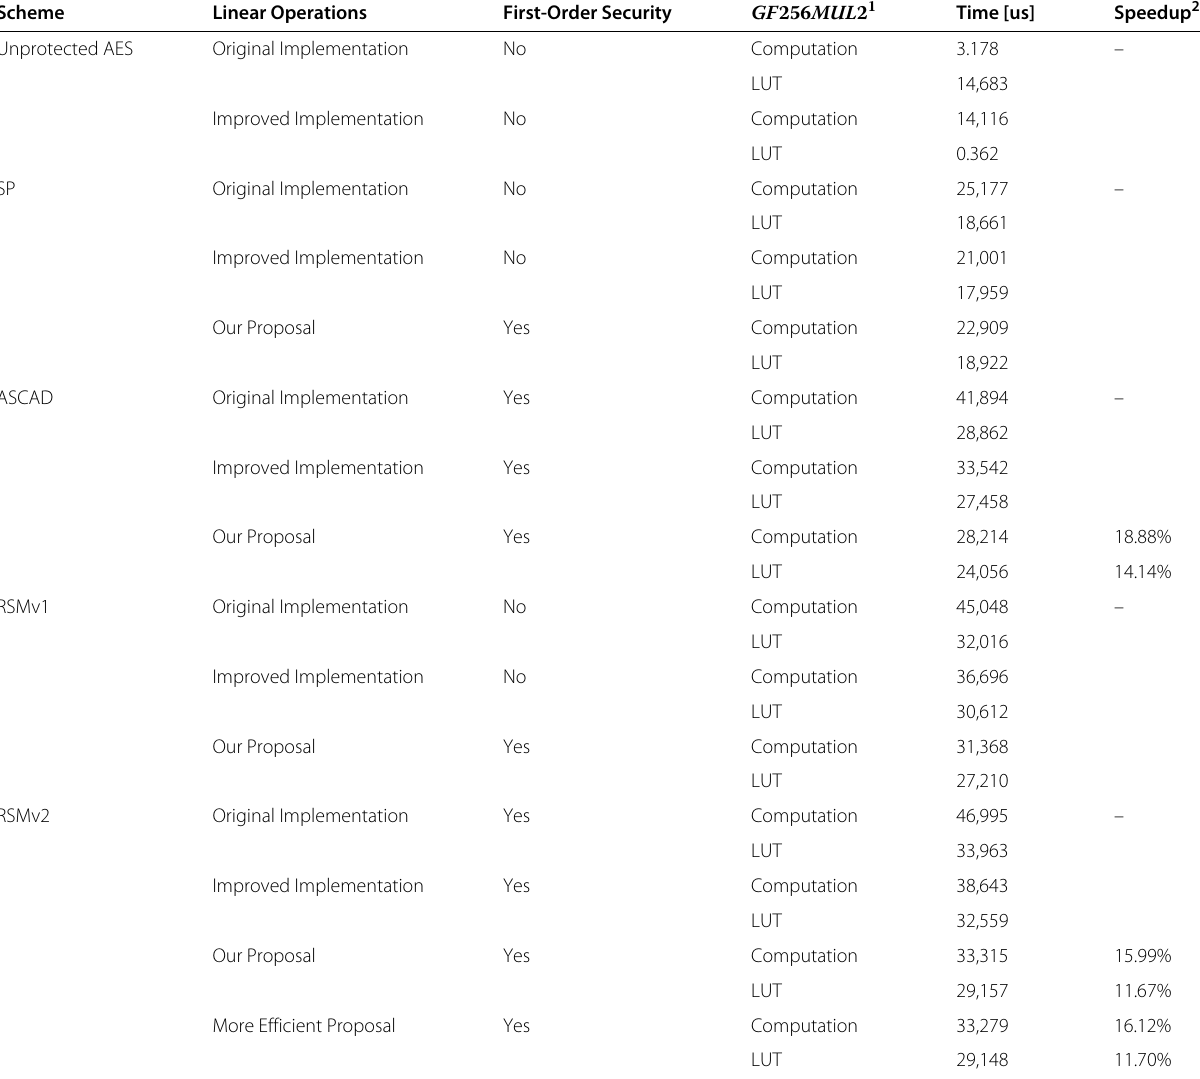
Table 8 Speedup in popular first-order masking schemes on an Cortex-M4 using simulator